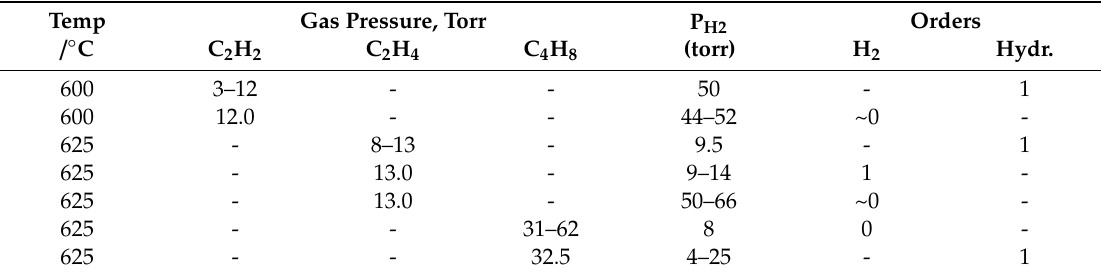
Table 3. Orders of reaction observed (Route I, surface reaction-step controlling region): Order 1 at low pressures, order 0 at higher pressures (Langmuir–Hinshelwood mechanism)